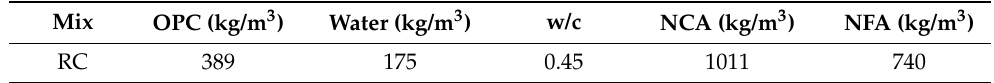
Table 1. Mix proportion of reference